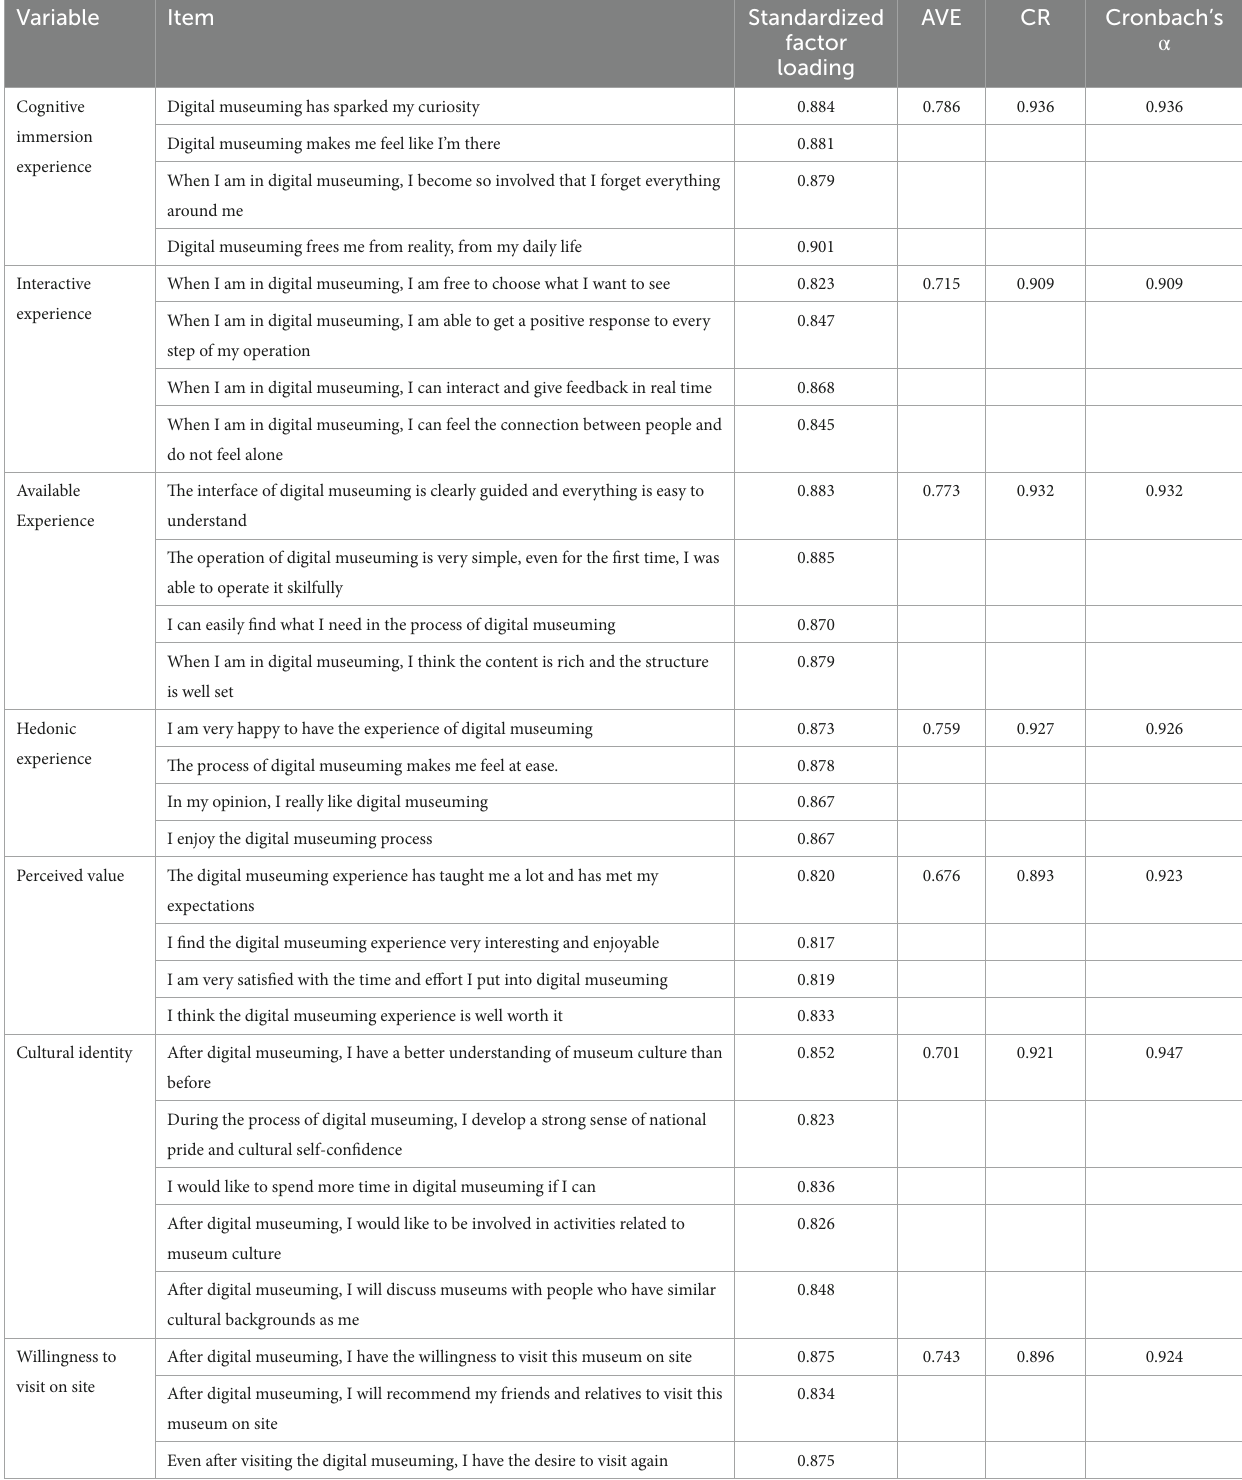
TABLE 2 Reliability and validity analysis. Variable Item Standardized